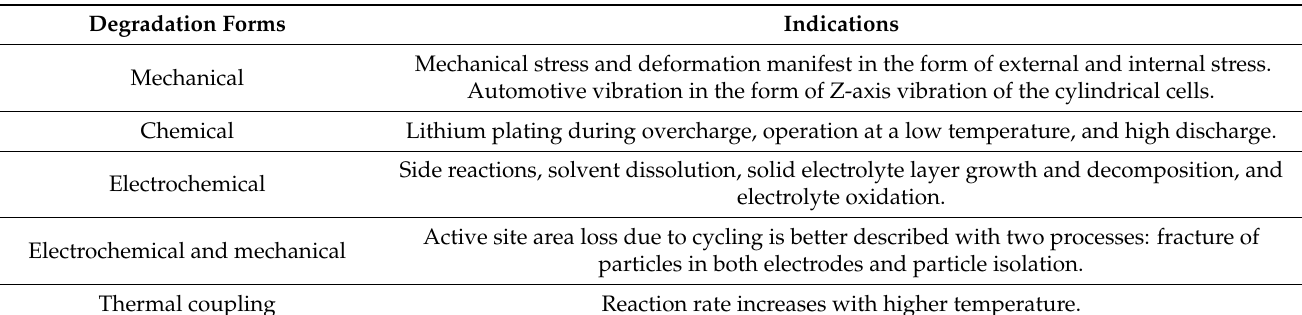
Table 2. Degradation mechanisms and noticeable signs associated with each mechanism [43,71–74]. Degradation Forms Indications Mechanical stress and deformation manifest in the form of external and internal stress. Mechanical Automotive vibration in the form of Z-axis vibration of the cylindrical cells. Chemical Lithium plating during overcharge, operation at a low temperature, and high discharge. Side reactions, solvent dissolution, solid electrolyte layer growth and decomposition, and Electrochemical electrolyte oxidation. Active site area loss due to cycling is better described with two processes: fracture of Electrochemical and mechanical particles in both electrodes and particle isolation. Thermal coupling Reaction rate increases with higher